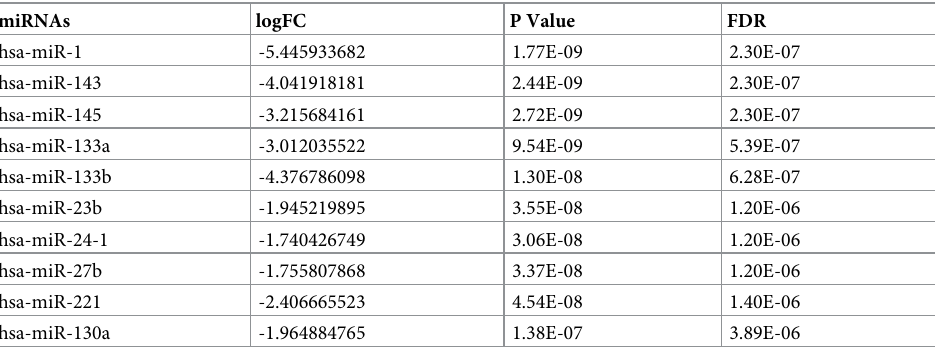
Table 2. Top 10 differential miRNAs for prostate cancer.